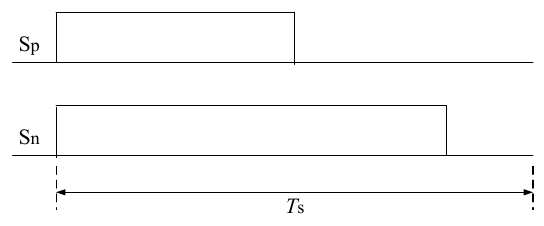
Figure 6. Driving waveforms of two switches in one-cycle control.